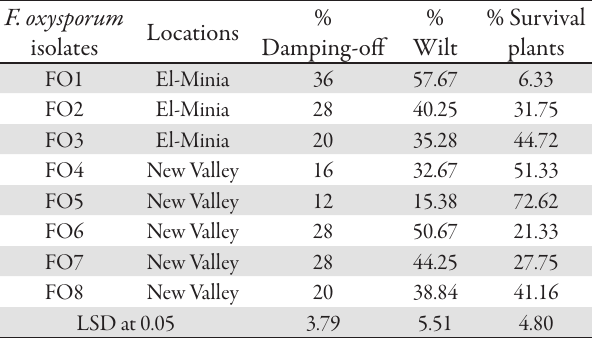
Tab. 1. Pathogenicity with Fusarium oxysporum isolate isolated from soybean roots collected from El- Minia and New Valley